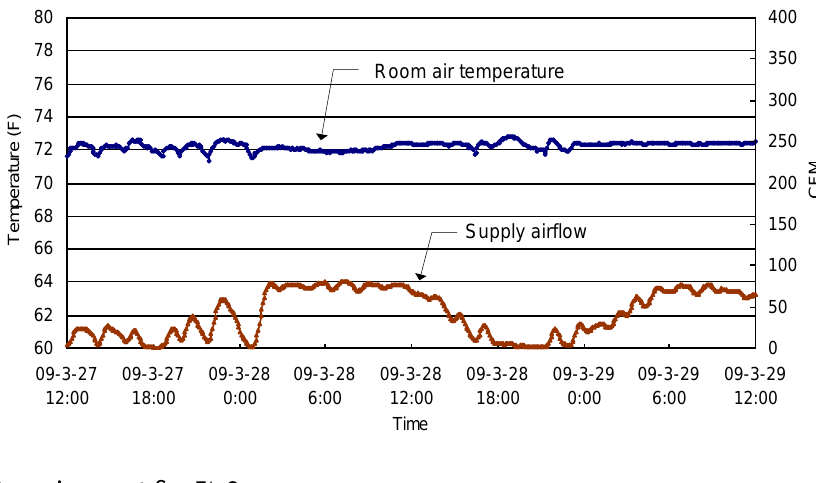
Figure 9. Trending data of room air temperature and airflow